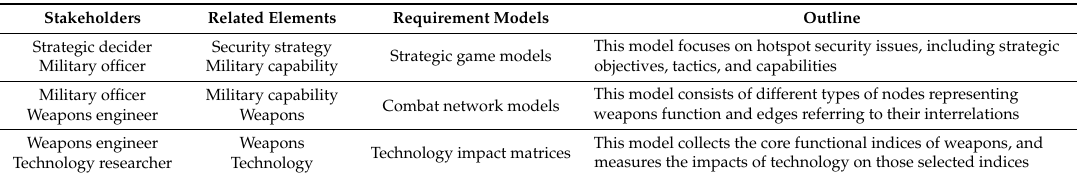
Table 1. Requirement analysis models for defense